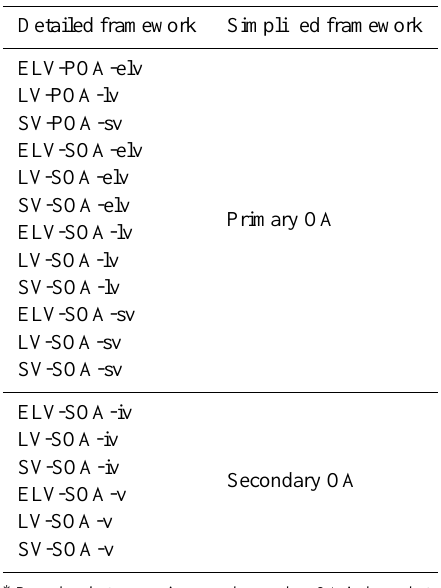
Table 7. Mapping of terms from simplified framework to proposed detailed framework ∗ . Detailed